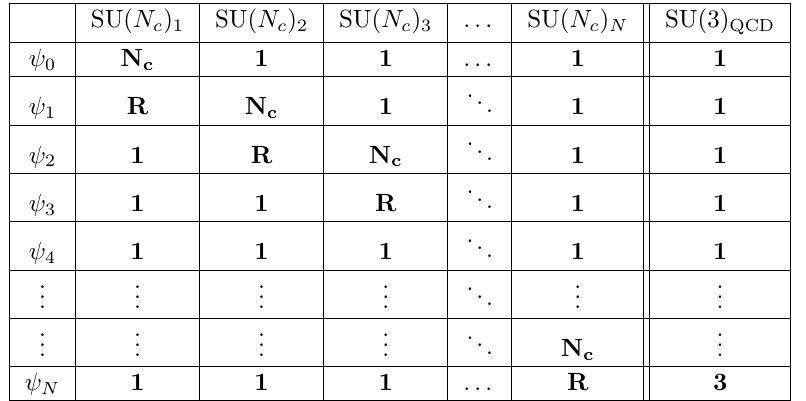
Table 1 . Structure of nearest neighbour couplings embedded in an SU( N c ) N gauge